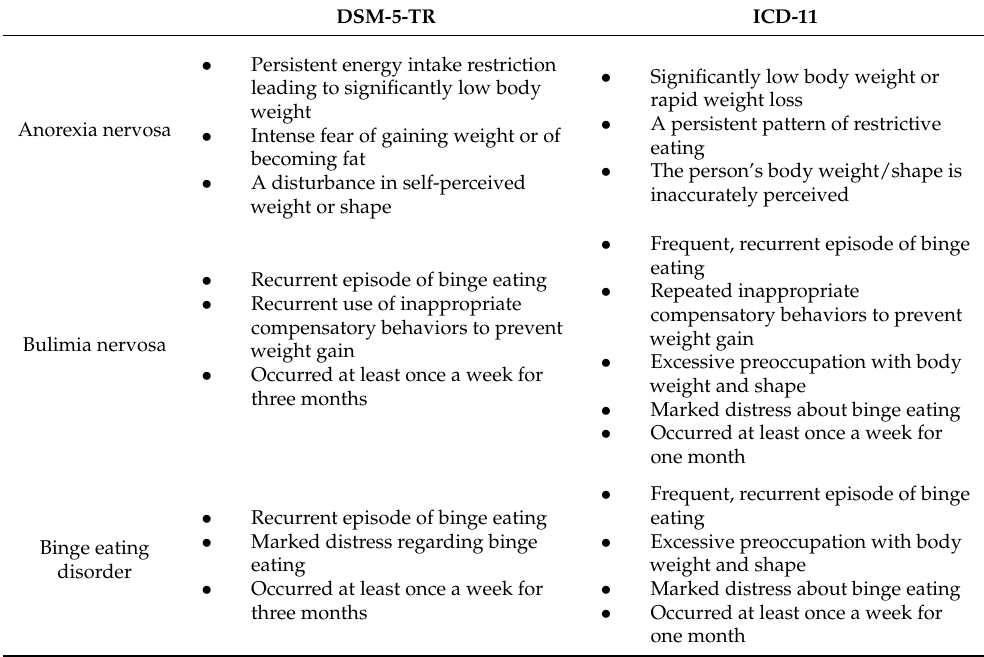
Table 1. Definition of major eating disorders [13,14]